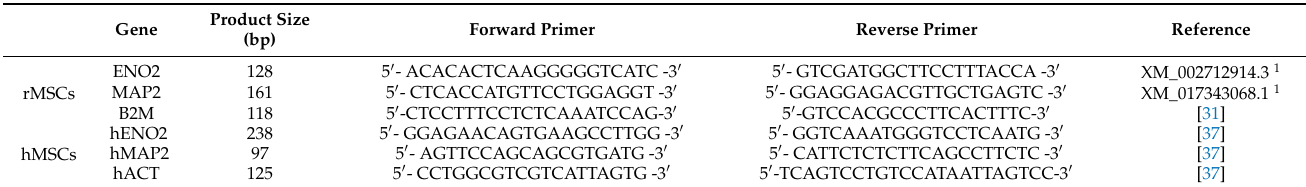
Table 4. Nucleotide sequences and size of RT-qPCR